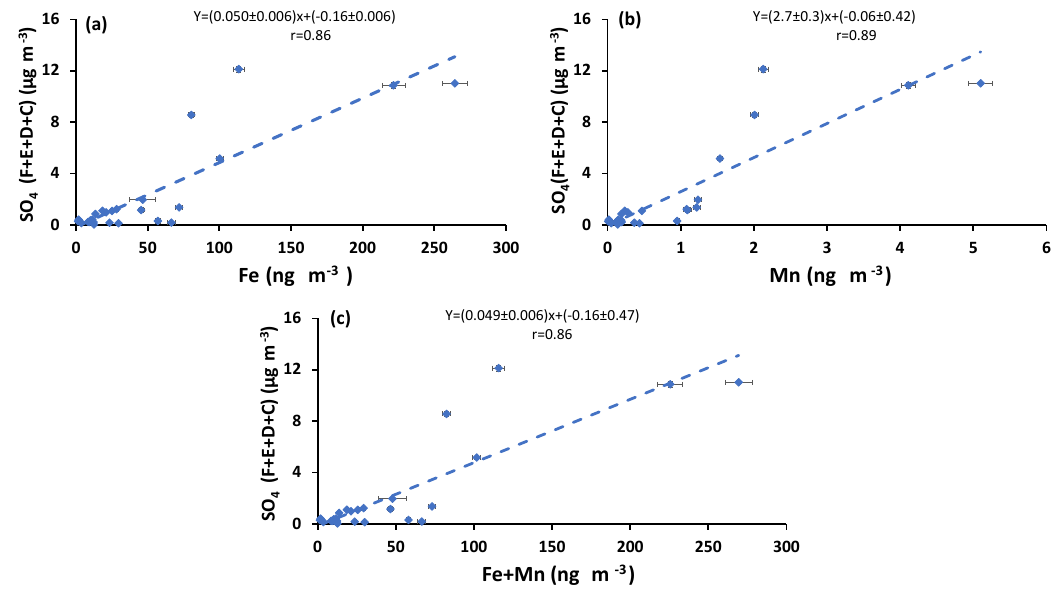
Figure 6. Sum of concentrations of sulfate in size ranges F < 0 . 49µm , E 0 . 49 − 0 . 95µm , D 0 . 95 − 1 . 5µm , and C 1 . 5 − 3 . 0µm versus the concentration of (a) Fe, (b) Mn, and (c) Fe + Mn.